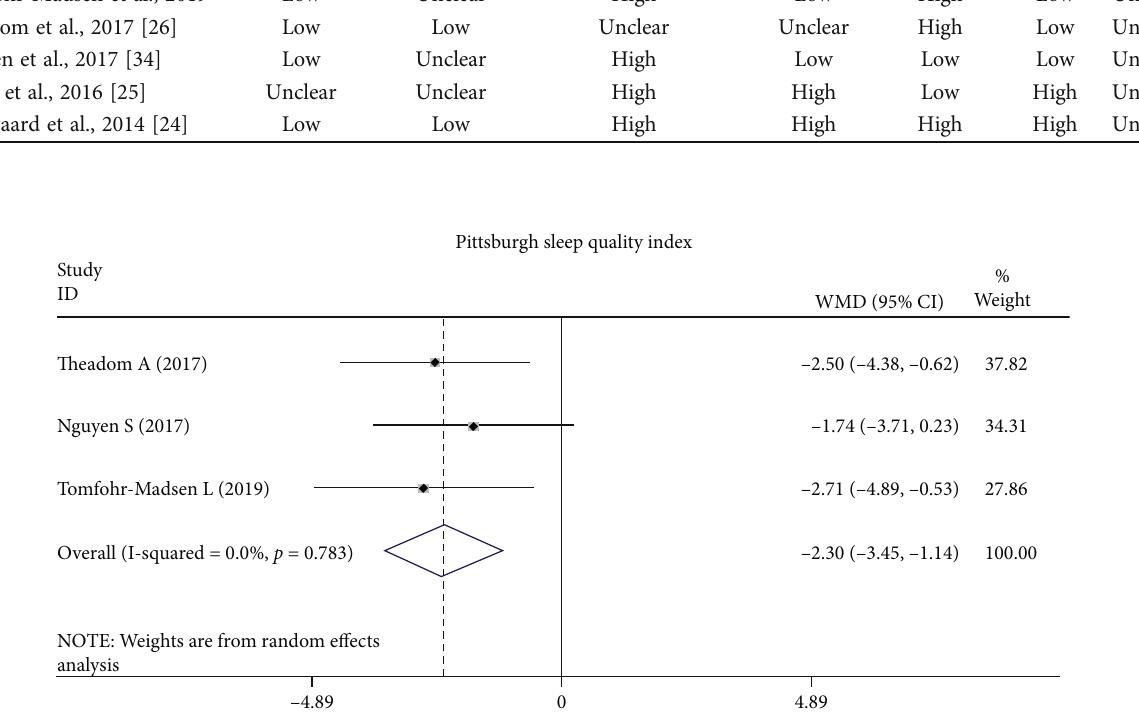
Figure 2: Di ff erences in Pittsburgh Self-Reported Sleep Quality Index scores following CBT compared with other forms of interventions.